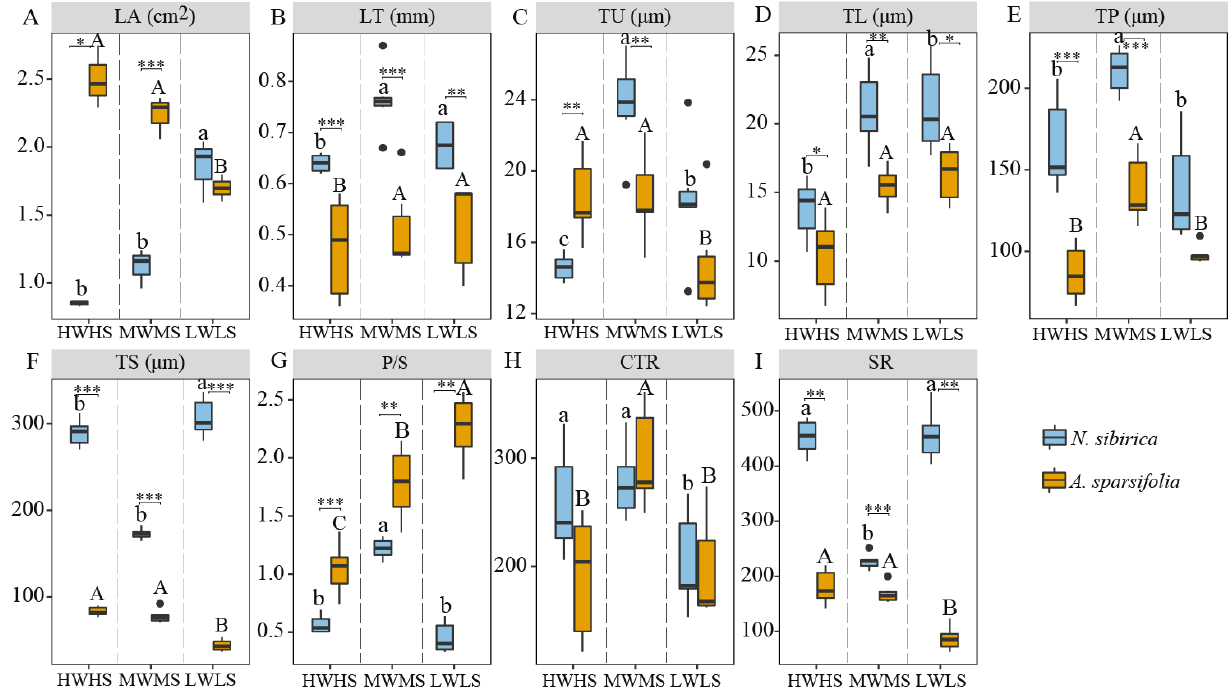
Figure 3. Changes in LA, LT, TU, TL, TP, TS, P/S, CTR, and SR of N. sibirica and A. sparsifolia under different plots. ( A ) Changes in LA (leaf area) of two plants; ( B ) Changes in LT (thickness of leaf) of two plants; ( C ) Changes in TU (thickness of upper epidermis) of two plants; ( D ) Changes in TL (thickness of lower epidermis) of two plants; ( E ) Changes in TP (thickness of palisade tissue) of two plants; ( F ) Changes in TS (thickness of sponge tissue) of two plants; ( G ) Changes in P/S (the palisade tissue and spongy tissue ratio) of two plants; ( H ) Changes in CTR (the tightness of palisade tissue) of two plants; ( I ) Changes in SR (the looseness of palisade tissue) of two plants. Different lowercase letters (a, b, c) above the error bars indicate the same index of N. sibirica under different plots ( p ≤ 0.05). Different capital letters (A, B, C) above the error bars indicate the same index of A. sparsifolia under different plots ( p ≤ 0.05). *, **, ***, indicate that F values were significant at p ≤ 0.05, 0.01, 0.001, respectively.